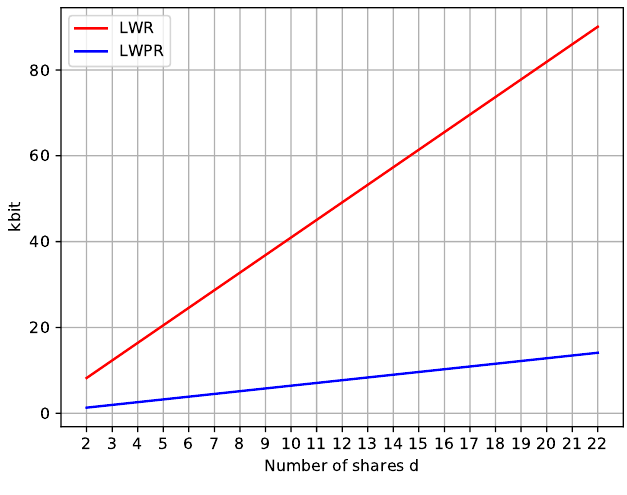
Figure 7: Key storage in function of the number of